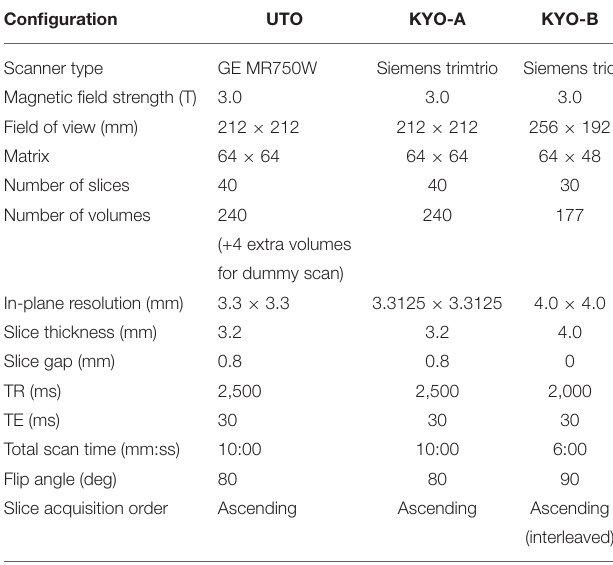
TABLE 1 | MRI scanning information for UTO (the University of Tokyo) and KYO (Kyoto University) data.